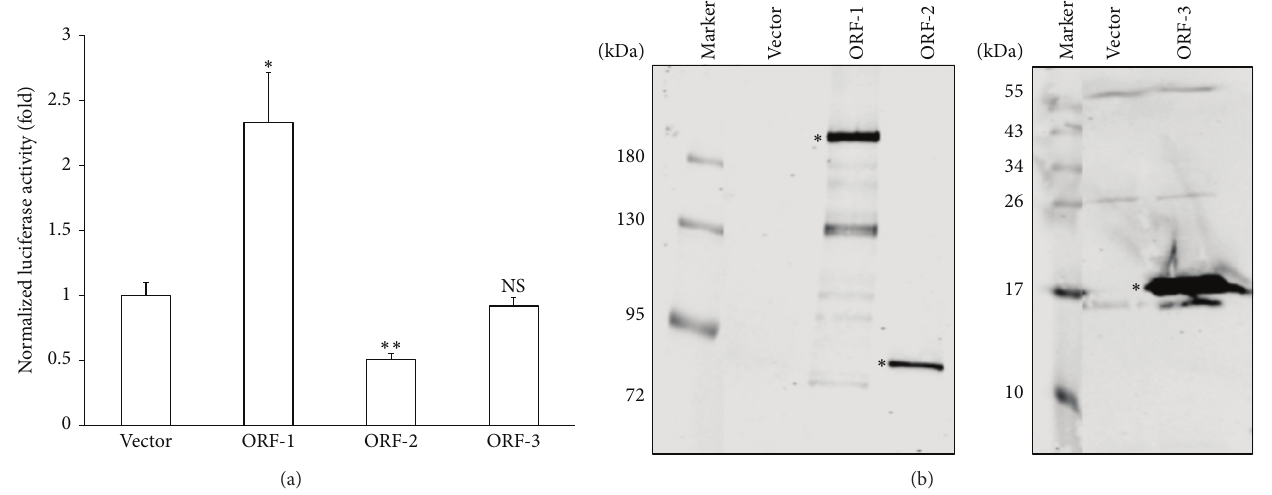
Figure 2: CXCL-8 transcriptional activation by HEV ORF-1. (a) HuH-7 cells were cotransfected with plasmid vector, or plasmids expressing HEV ORF-1, ORF-2, or ORF-3 proteins and the − 173 CXCL-8 promoter-luciferase reporter. Luciferase assay was performed 48 hours after transfection. Luciferase activity was normalized against the protein concentration of the same samples. ∗ : p ≤ 0.05, ∗∗ : p ≤ 0.01, and NS: not significant by Student’s t -test. (b) The expression of HEV ORF-1, ORF-2, or ORF-3 proteins with a N-terminal Flag-tag after transfection into HEK293 cells was analyzed by immunoprecipitation followed by Western blotting with an anti-Flag antibody. The location of HEV proteins was indicated by ∗ in the